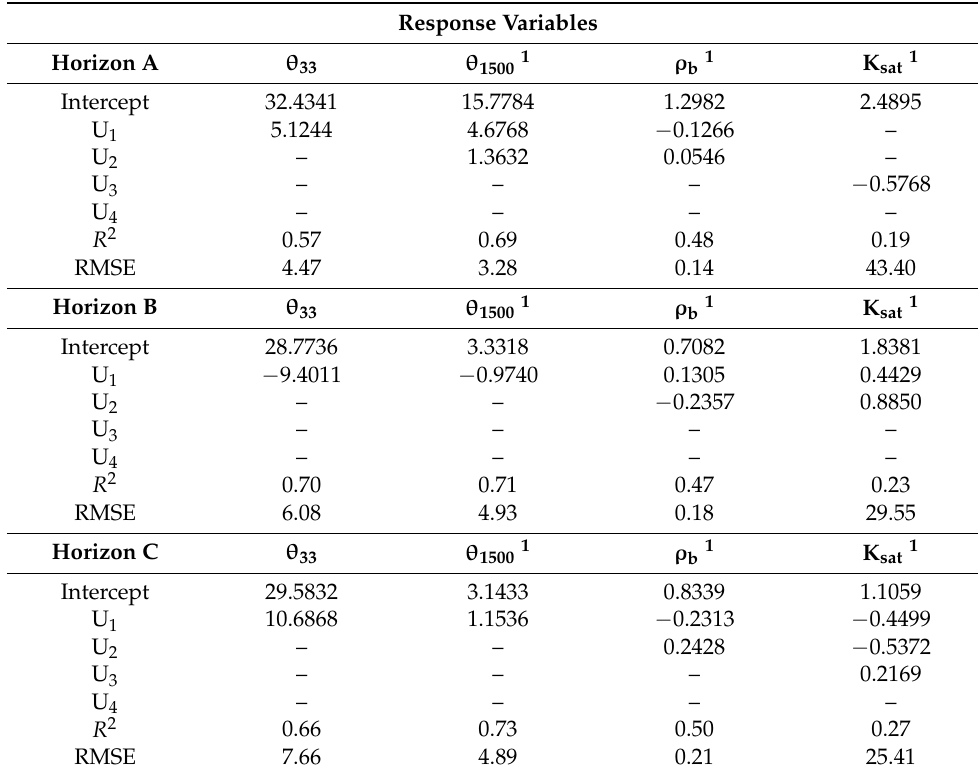
Table 7. Regression coefficients between canonical variables and response variables; p ≤